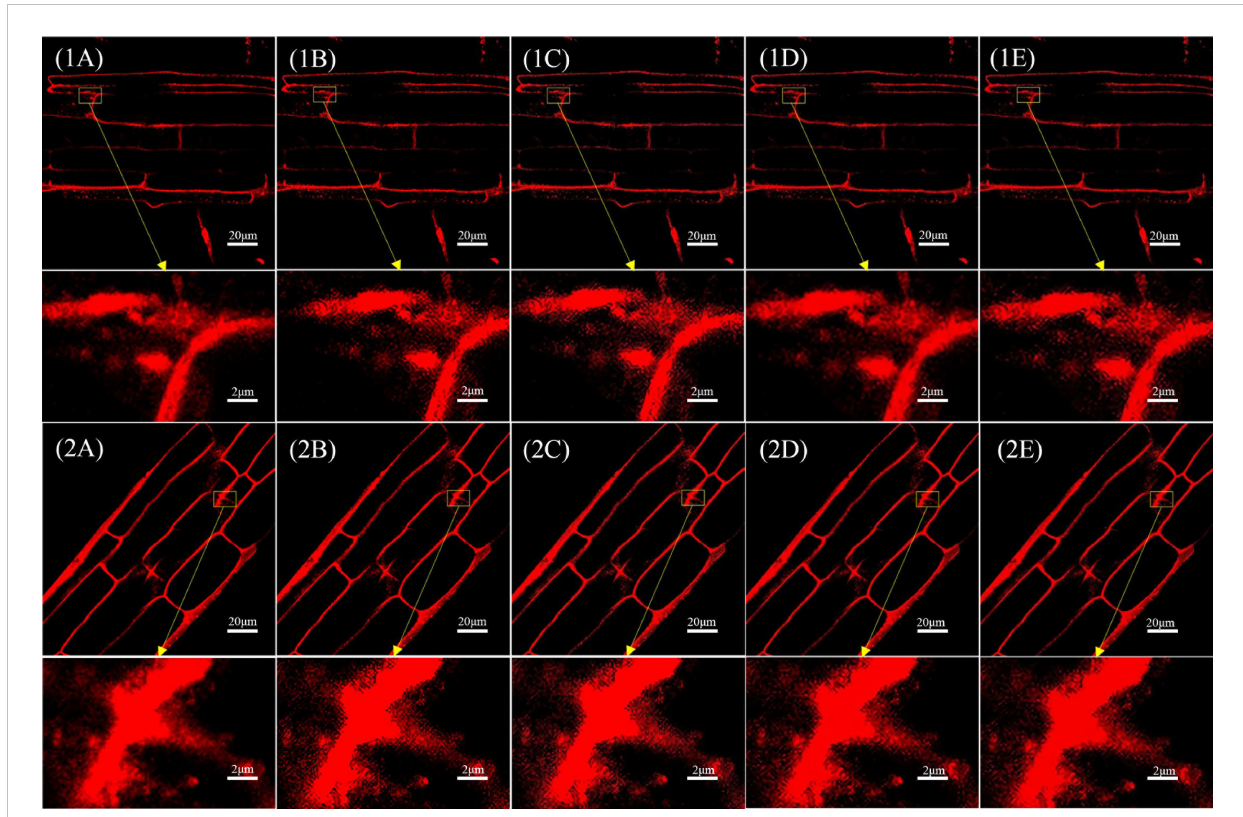
FIGURE 3 Comparison of single and secondary reconstruction images of different models in different images. (1A) Original image 1(pixel: 1024×1024) and local magni fi cation map(pixel: 102×66). (1B) SRGAN single-reconstruction image(pixel: 4096×4096) and local magni fi cation map(pixel: 410×264). (1C) SRGAN secondary-reconstruction image(pixel: 16384×16384) and local magni fi cation map(pixel: 1638×1056). (1D) SRResNet single- reconstruction image(pixel: 4096×4096) and local magni fi cation map(pixel: 410×264). (1E) SRResNet secondary-reconstruction image(pixel: 16384×16384) and local magni fi cation map(pixel: 1638×1056). (2A) Original image 2(pixel: 1024×1024) and local magni fi cation map(pixel: 102×66). (2B) SRGAN single-reconstruction image(pixel: 4096×4096) and local magni fi cation map(pixel: 410×264). (2C) SRGAN secondary-reconstruction image(pixel: 16384×16384) and local magni fi cation map(pixel: 1638×1056). (2D) SRResNet single-reconstruction image(pixel: 4096×4096) and local magni fi cation map(pixel: 410×264). (2E) SRResNet secondary-reconstruction image(pixel: 16384×16384) and local magni fi cation map(pixel: 1638×1056).